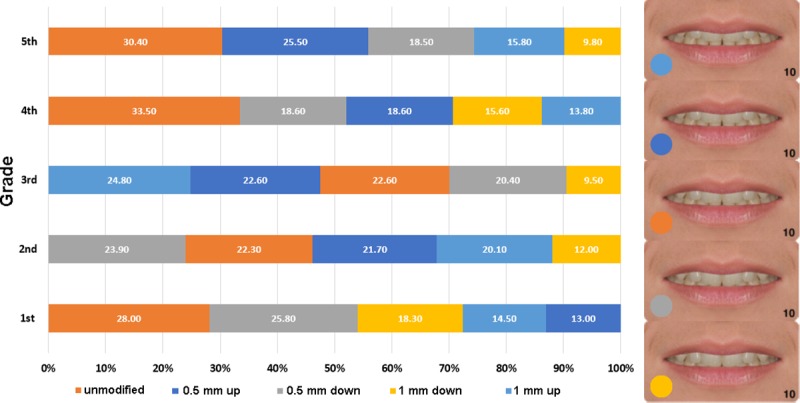
Distribution of preferences in the five grades for the relative visibility of the arches.The arches were moved upward and downward behind the lips in 0.5 mm steps (percentages, N = 861).